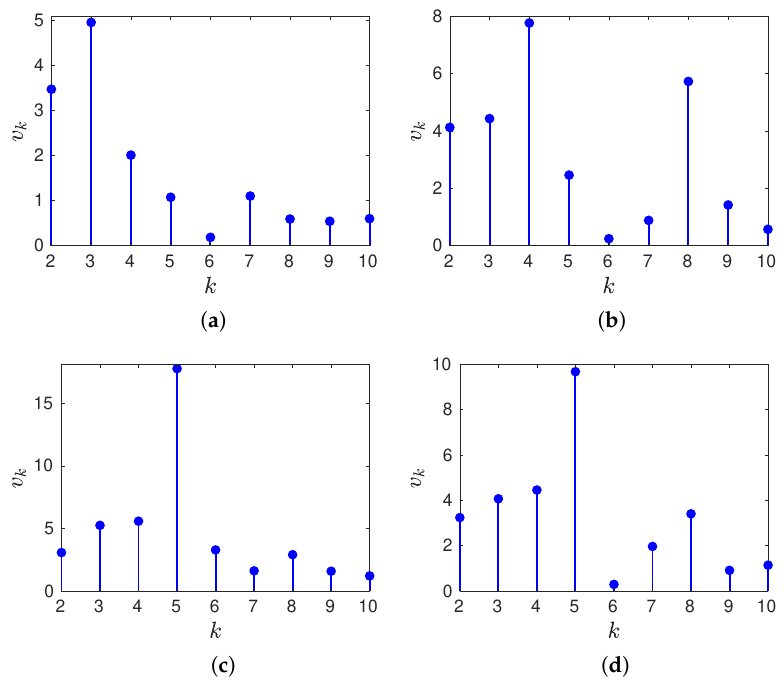
Figure 10. Sequence v k for ( a ) Samson, ( b ) Jasper Ridge, ( c ) Urban, and ( d ) Washington